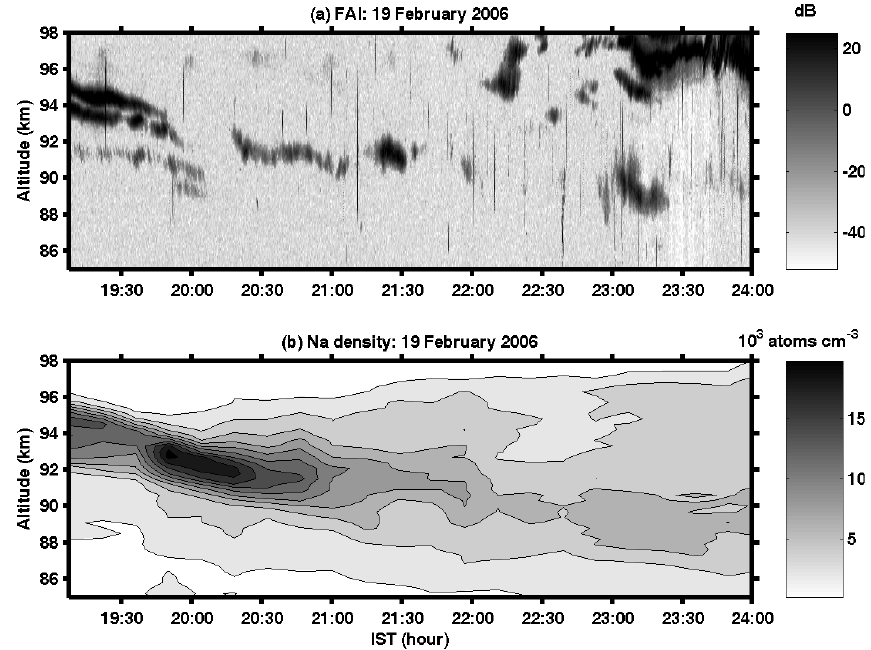
Fig. 2. Altitude-time cross section of intensity of echoes from FAI (top panel) and sodium density (bottom panel) for 19 February